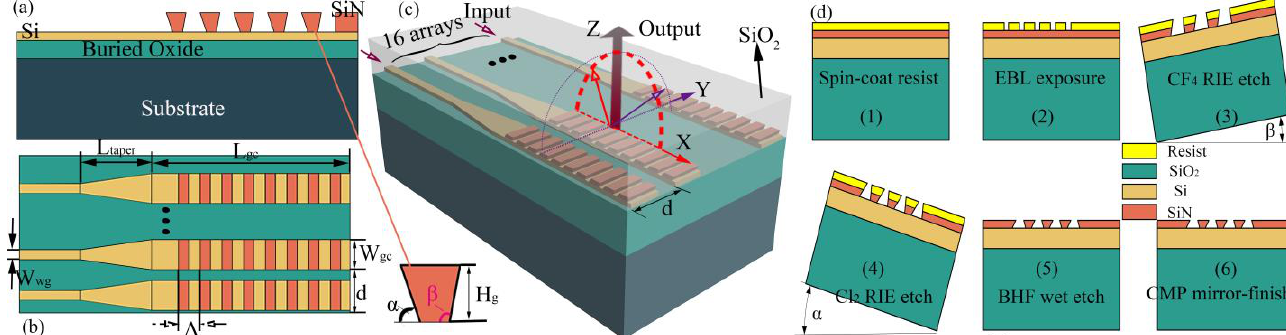
Figure 1. Schematic diagram of the structure and processing process of the proposed antenna. ( a ) Side view of the antenna; ( b ) top view of the antenna; ( c ) schematic of the antenna for optical phased arrays of integrated light detection and ranging (LIDAR) on silicon on insulator (SOI) substrate; ( d ) the essential step-by-step flow chart of the fabrication process. EBL, electron-beam lithography; PECVD, plasma-enhanced chemical vapor deposition; CMP, chemical–mechanical polishing [20].